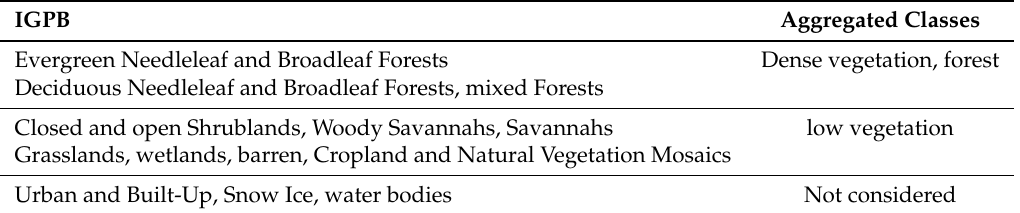
Table 1. IGBP land cover classification, grouped into aggregated